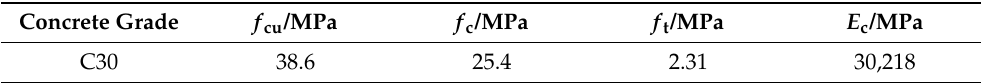
Table 1. Mechanical properties of concrete.